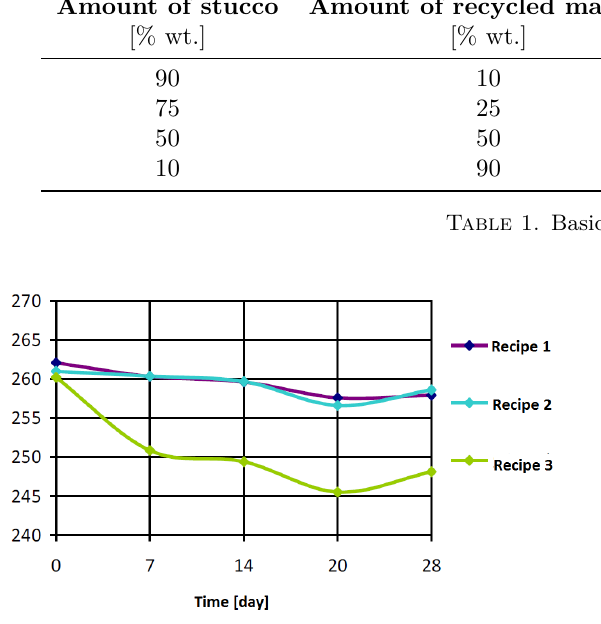
Figure 5. Volume changes over time – recycled blocks [8].